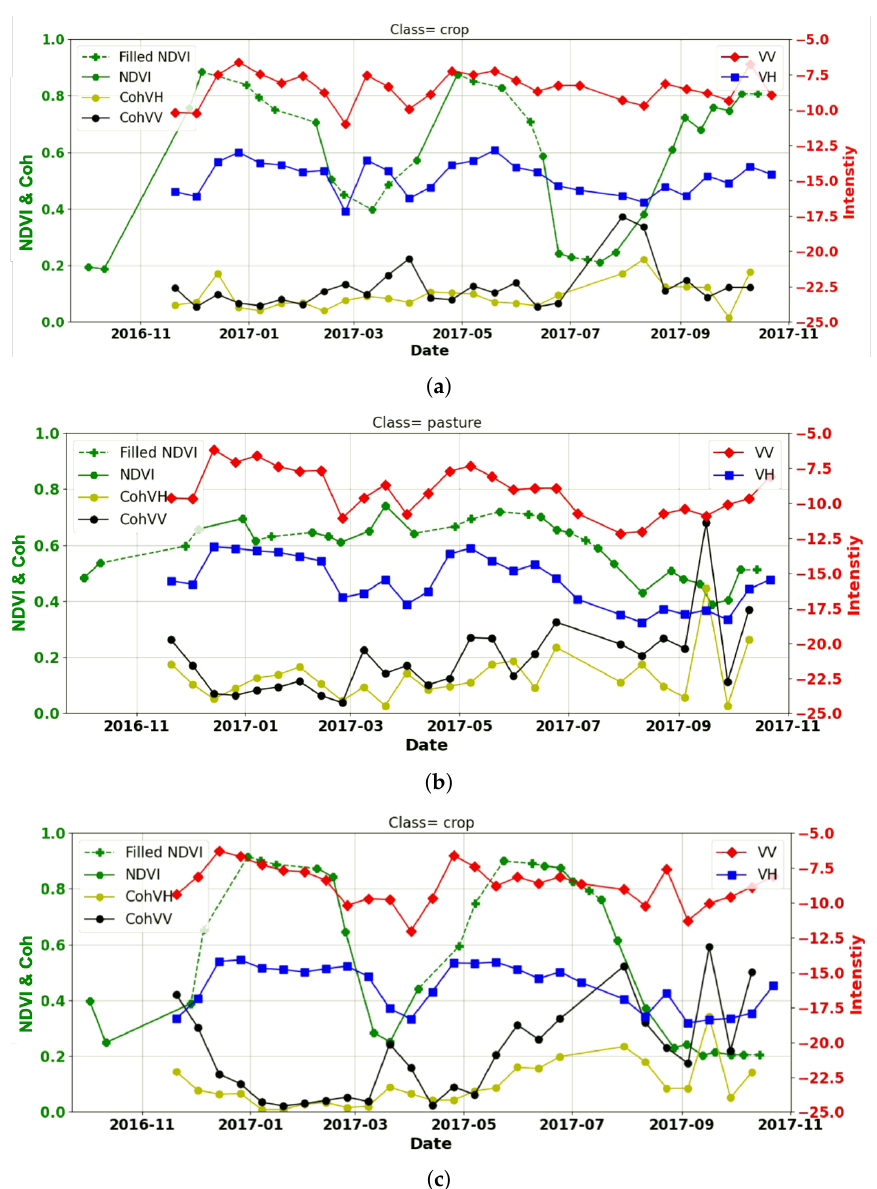
Figure 11. SAR and optical time-series over different land covers: ( a ) for a field that is only correctly classified with the combined use of coherence and amplitude; ( b ) for a field that is only correctly classified by the exclusive use of the amplitude; and ( c ) for a field that is correctly classified with both